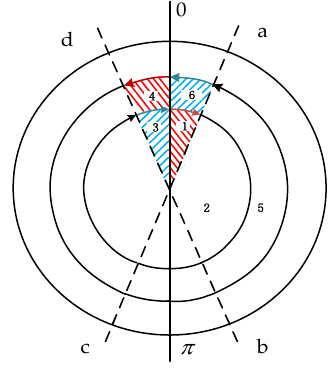
Figure 8. Single reciprocating rotation.